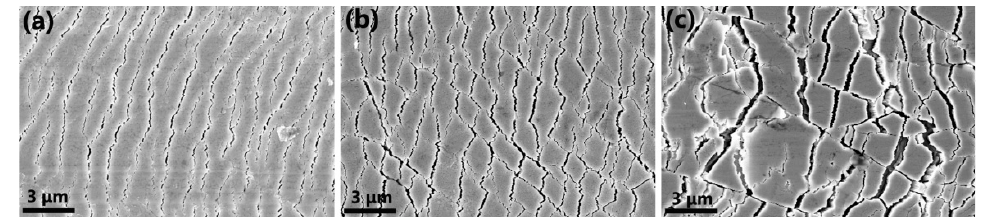
Figure 19. SEM image of the microstructure of the coatings scratches: ( a ) CrN, ( b ) CrN-Pt, ( c ) CrN-3Pt.